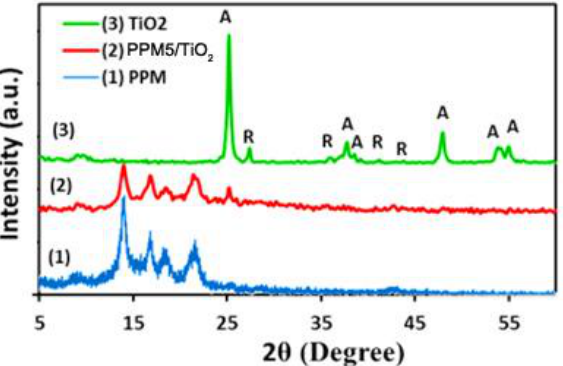
Figure 3. X-ray diffraction (XRD) patterns of ( 1 ): polypropylene membrane, ( 2 ): PPM5/TiO 2 and ( 3 ): Figure 3. X-ray di ff raction (XRD) patterns of ( 1 ): polypropylene membrane, ( 2 ): PPM5 / TiO 2 and ( 3 ): TiO 2 (A: anatase, R: rutile). TiO 2 (A: anatase, R: rutile).